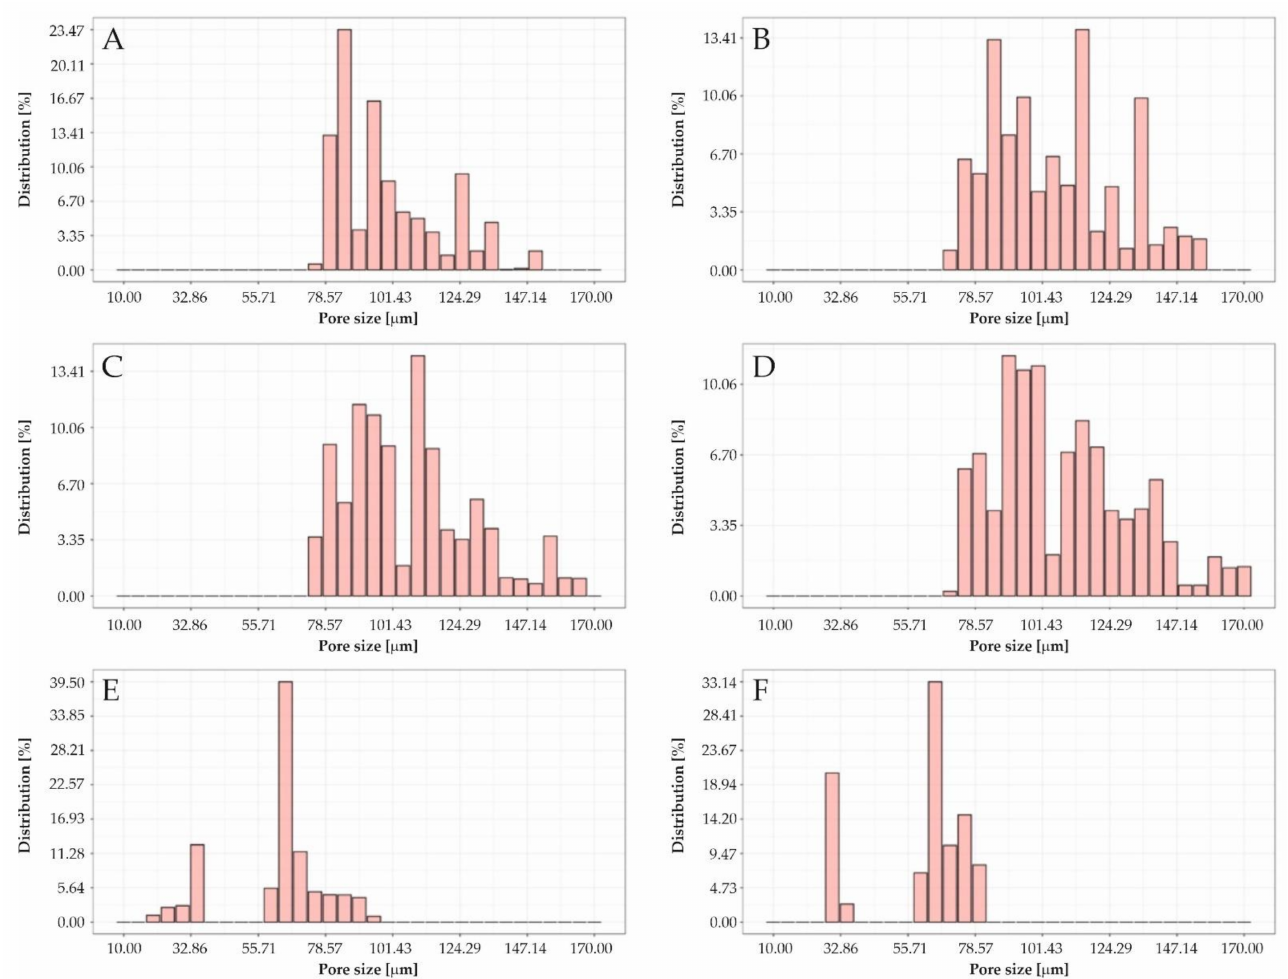
Figure 3. Histograms of pore size distributions for the different non-modified and modified non- wovens are shown, namely for ( A ) initial state (I), ( B ) initial state and graphene (I + G), ( C ) hy- drophilic agent (Hy), ( D ) hydrophilic agent and graphene (Hy + G), ( E ) functional coating (FC), and ( F ) functional coating and graphene (FC +